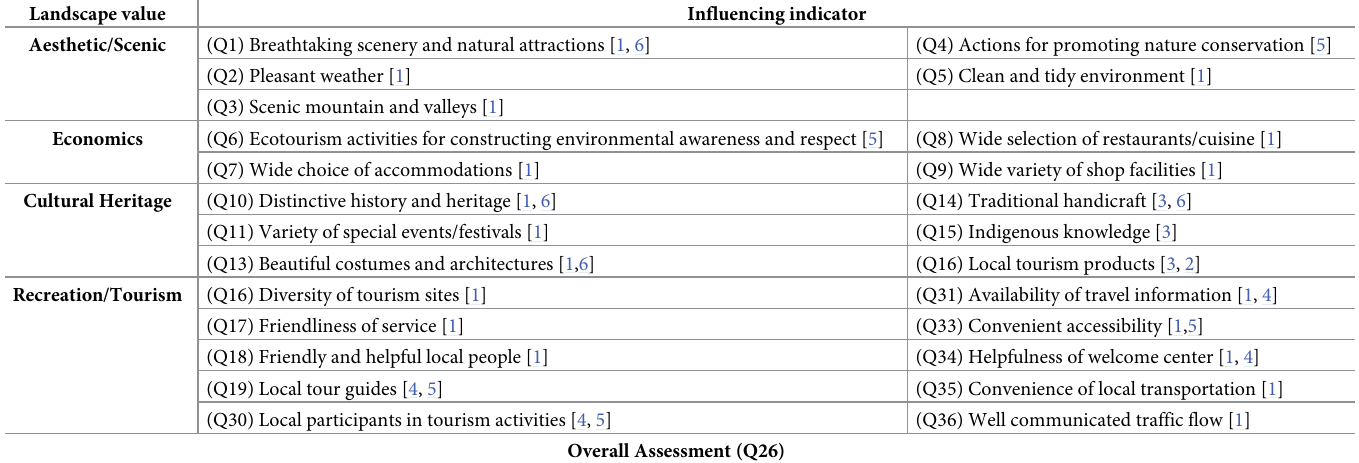
Table 1. Describing landscape values for tourism used in the stakeholder surveys for landscape assessment. Landscape value Influencing